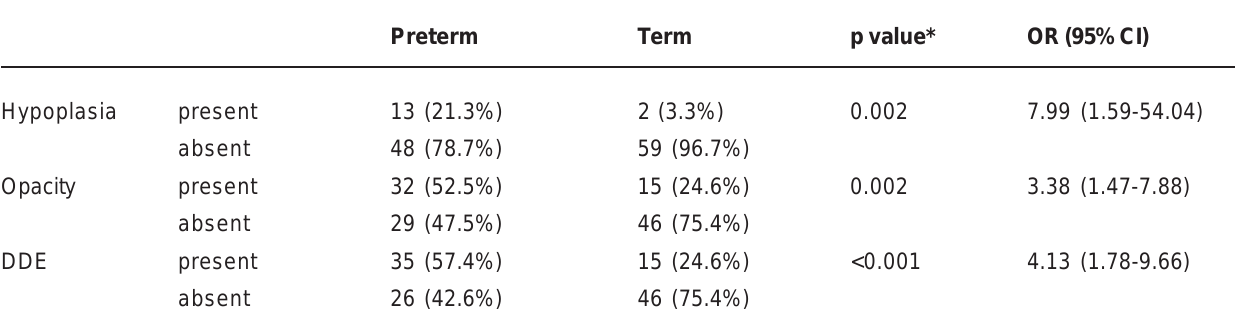
TABLE 2- Enamel defects in deciduous dentition in children born preterm with low birth weight compared to full-term controls